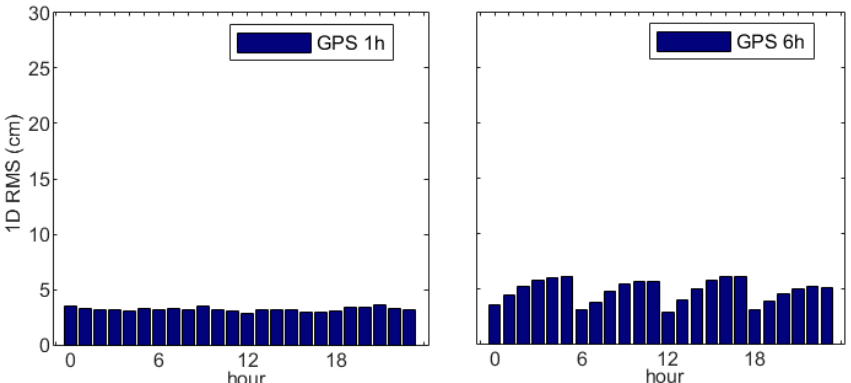
Figure 7. Accuracy of GPS ultra-rapid predicted orbit updated per 6 h and GPS ultra-rapid predicted orbit updated per 1 h.